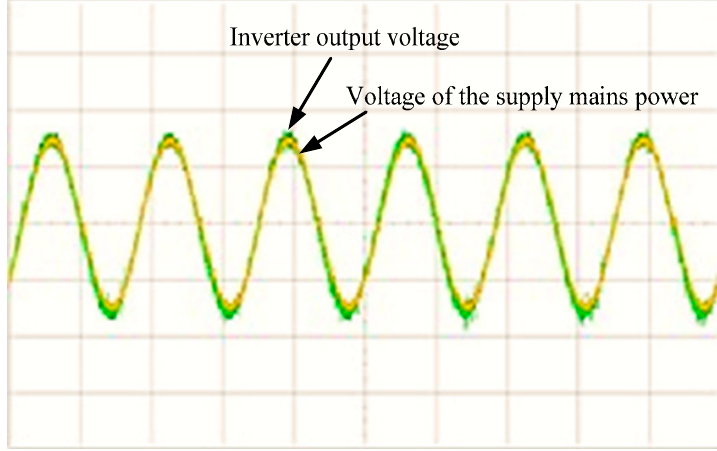
Figure 18. Waveform of the alternating current (AC) power converted from the DC power.